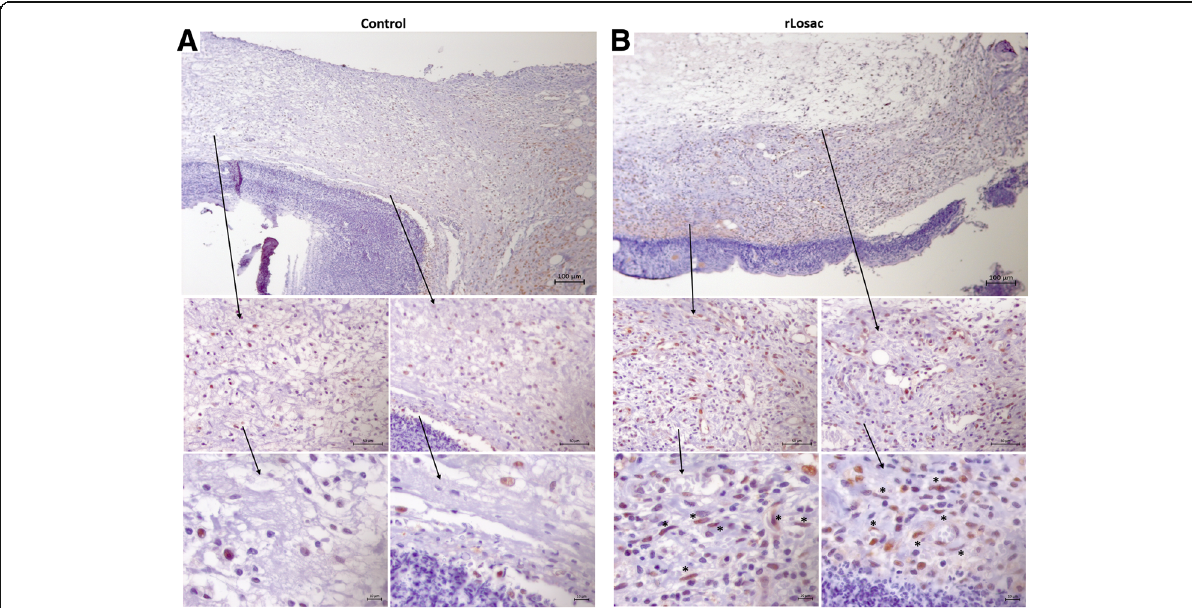
Fig. 4 Representative micrographies of immunohistochemistry for PCNA. Assessment of scar tissue by PCNA immunohistochemistry (proliferating